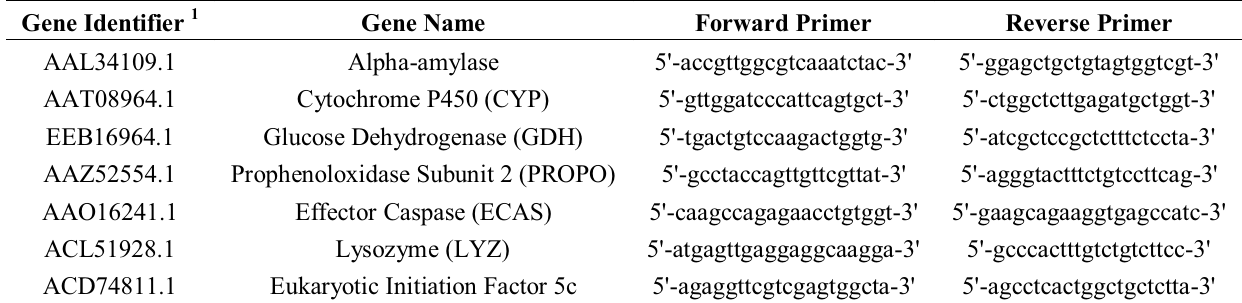
Table 1. Primers designed to verify gene regulation in the gut